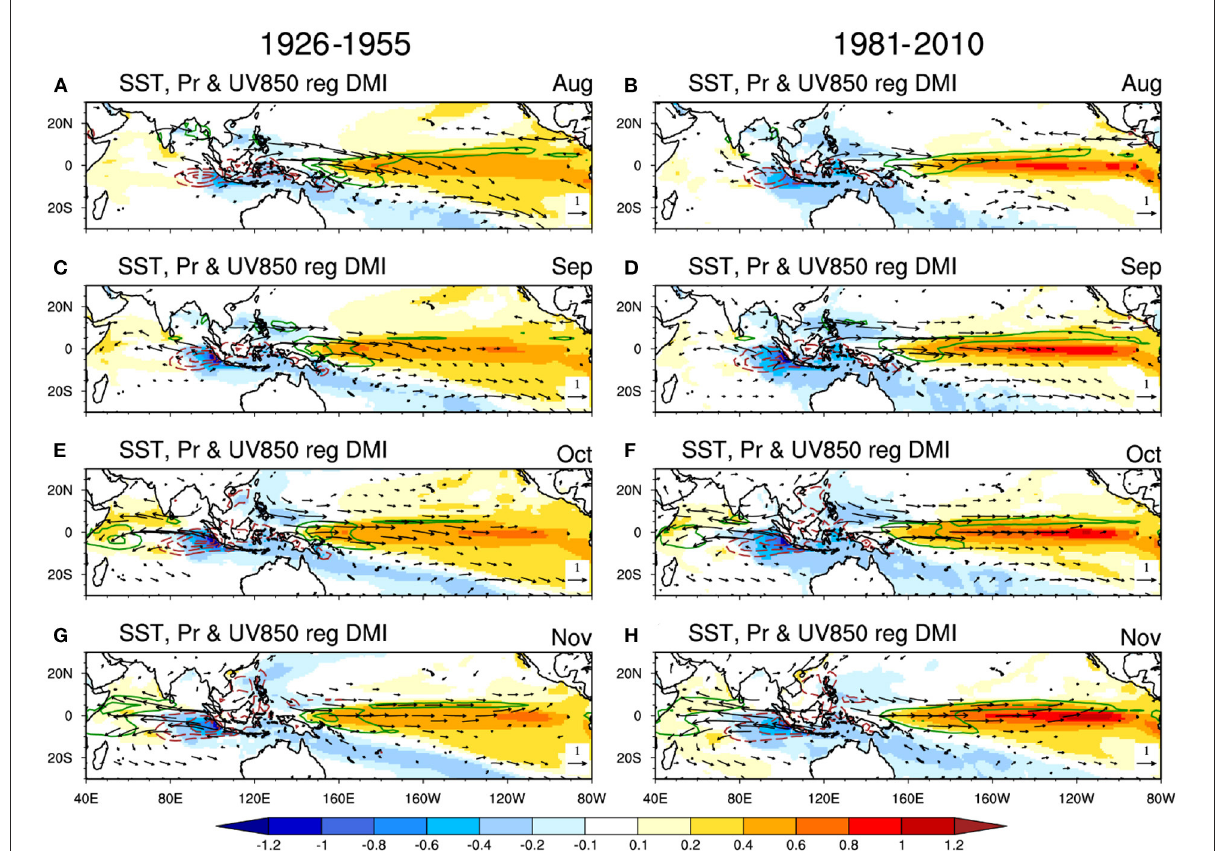
FIGURE6 Left: Regression of monthly SSTA (shading, unit: ◦ C), precipitation (contour, unit: mm/day), and 850-hPa wind anomalies (vector, unit: m/s) onto the standardized SON-mean DMI index from the ensemble mean predictions in the period 1926–1955: (A) August, (C) September, (E) October, and (G) November. Only values reaching the 5% significance level are shown. Right: (B, D, F, H) as in (A, C, E, G) , but for the regression in the period